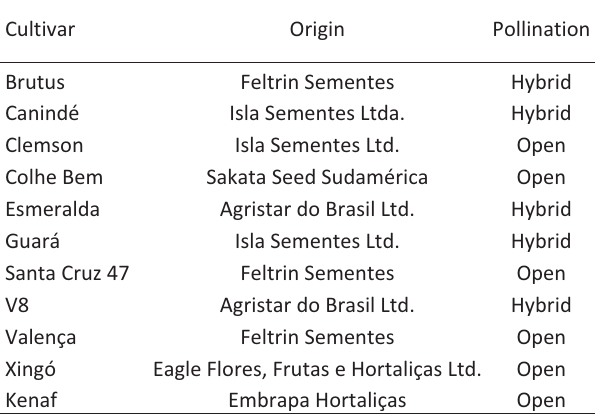
Table 1 ­ Identification and origin of the okra and Hibiscus geno­ types used in the